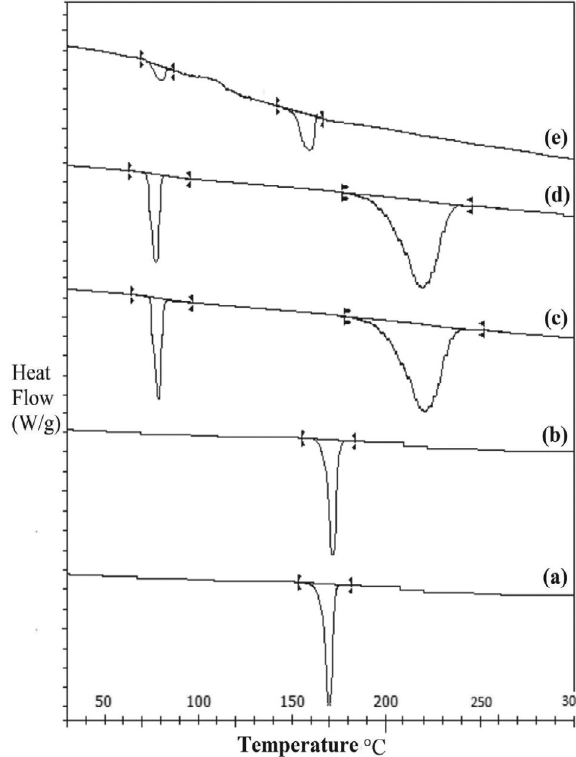
Figure 2. DSC thermogram of (a) PA, (b) BMP, (c) IB, (d) BMI and (e) COAM